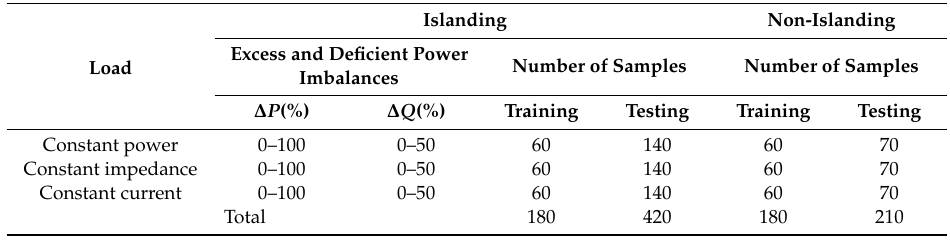
Table 4. Division of training and testing samples for di ff erent types of loads in islanding and non-islanding scenarios.